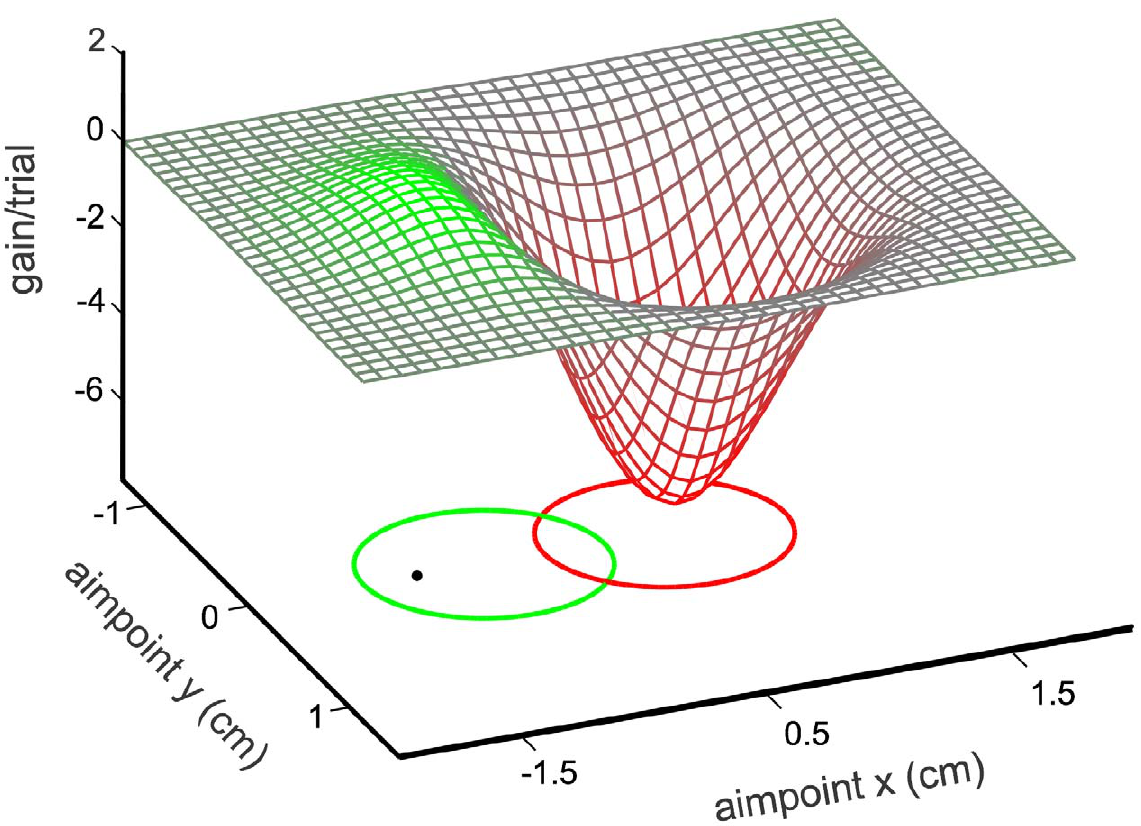
Figure 1. Example stimulus with superimposed expected gain landscape. In our task, subjects made rapid pointing movements at a frontoparallel screen to hit a green target circle while avoiding an overlapping red penalty circle (here shown on the x-y plane). For this illustration, hits on the green circle result in a reward of 1 point and hits on the red circle yield a penalty of 5 points. This figure shows the expected gain per trial associated with different aimpoints for a simulated subject with a circular Gaussian movement uncertainty of 3 mm standard deviation. The optimal aimpoint maximizing expected gain (MEG aimpoint) is the filled circle marked within the green target region.